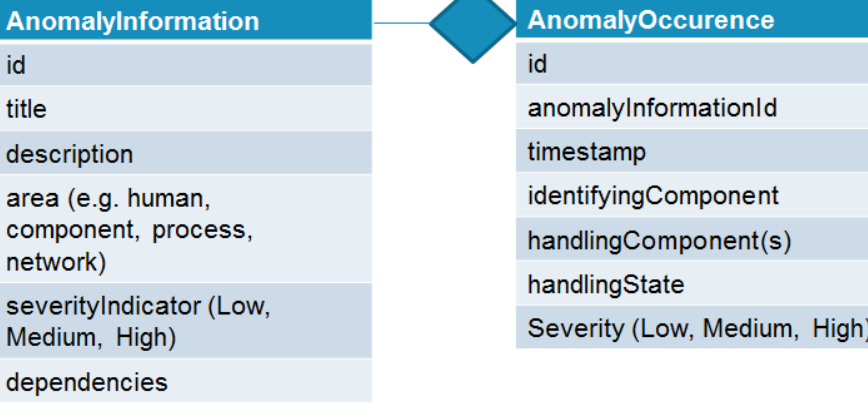
Figure 2. Anomaly